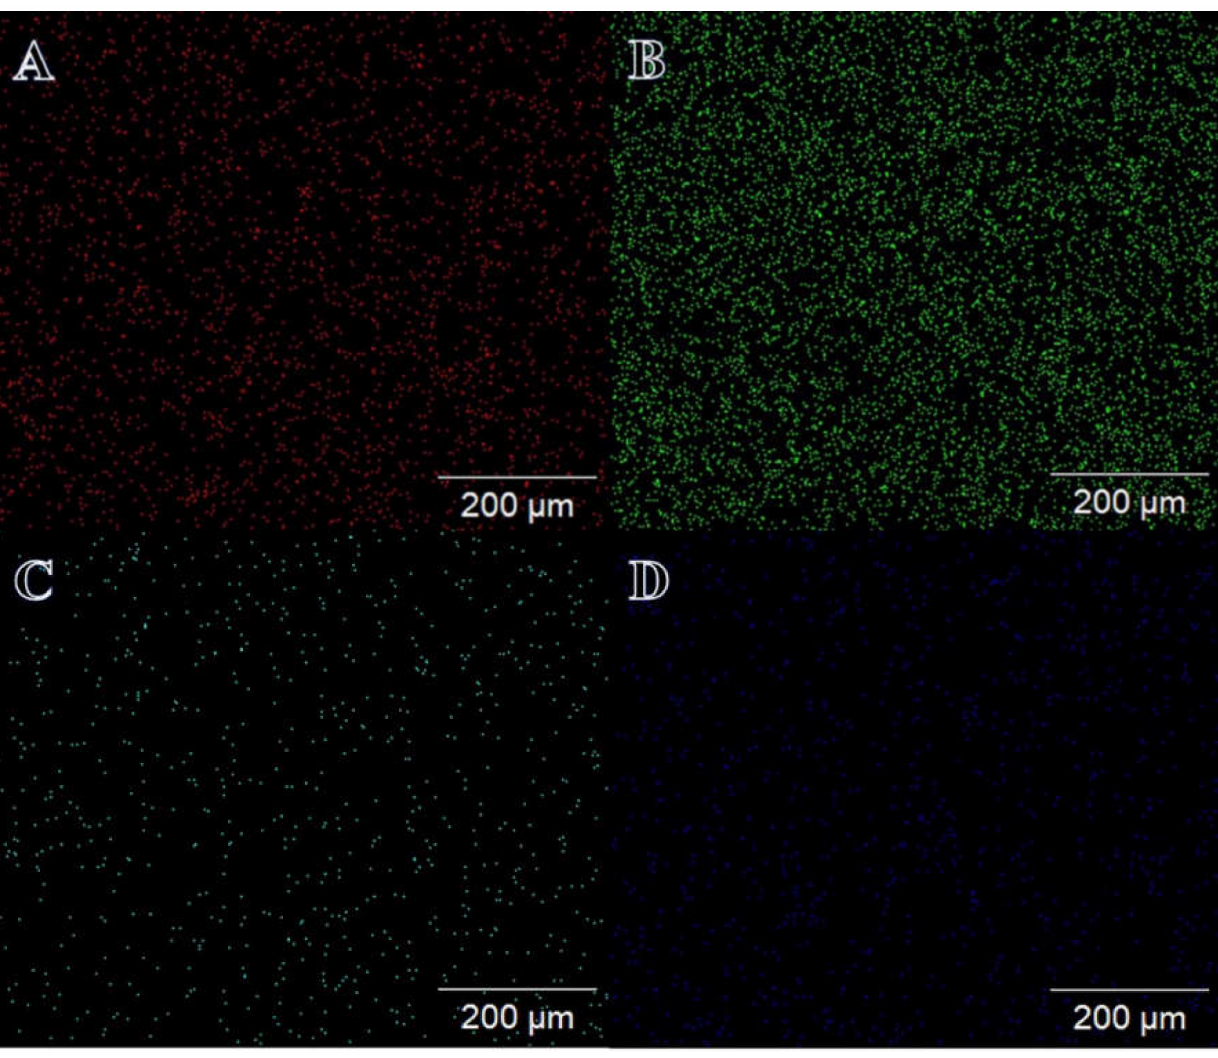
Figure 1C–F show SEM images of electrospun Ni 0.3 Cu 0.7 -PVDF-HFP and Ni 0.1 Cu 0.9 -